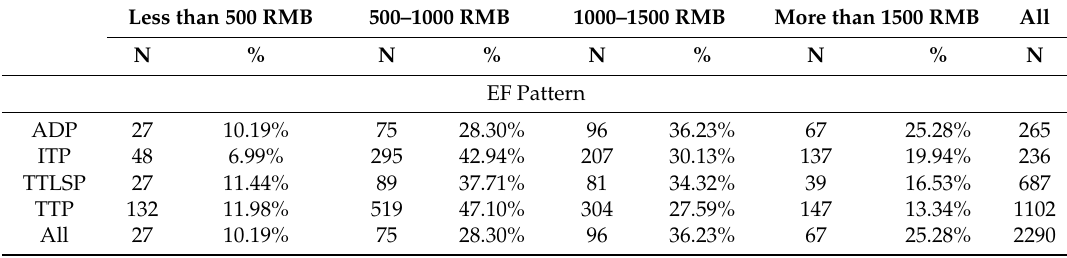
Table 4. Differences in food budget distribution among EF